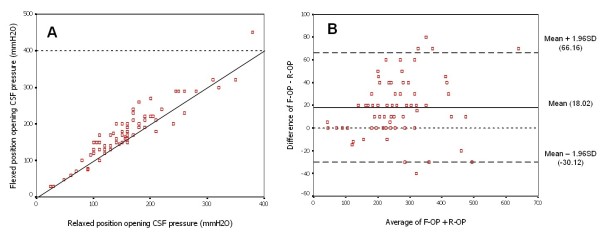
Correlation and agreement between flexed and relaxed opening CSF pressure measurement in patients in the lateral recumbent position: 1A. Scatter plot showing the positive correlation between the opening pressure in the flexed position and the opening pressure in the relaxed position; however, the pressure values in flexed position tend to exceed those in the relaxed position as shown in the area between straight line (agreement line) and dot line (showed the F-OP value of 400 mmH2O). 1B. Bland-Altman plot showing the relation between the difference between F-OP and R-OP and the mean of F-OP and R-OP. There is a significant disagreement between the pressure values in different positions. The average of the difference (bias) is 18.02 (straight line) compared to the agreement line at zero (dotted) line. In addition, the 95% confidence of the bias is shown as the two dashed lines, which is between -30.12 and 66.16.